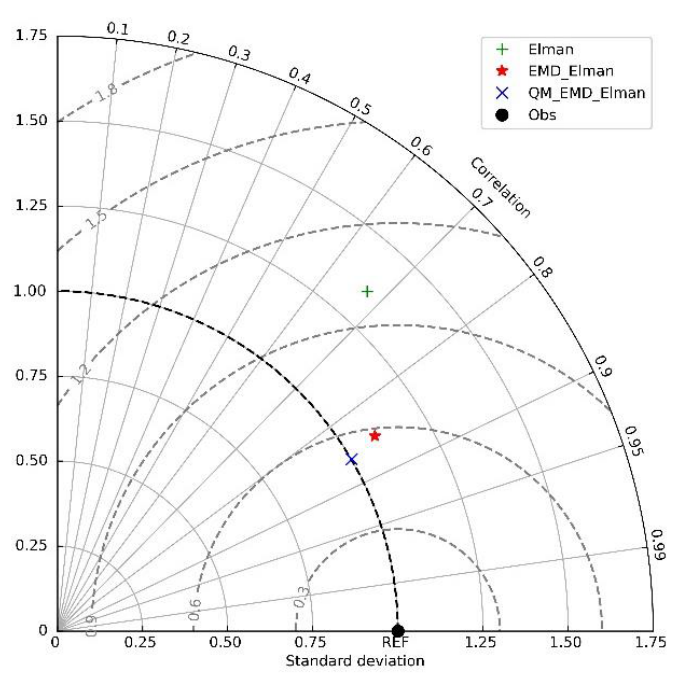
Figure 13. Taylor Figure 13. Taylor diagram.